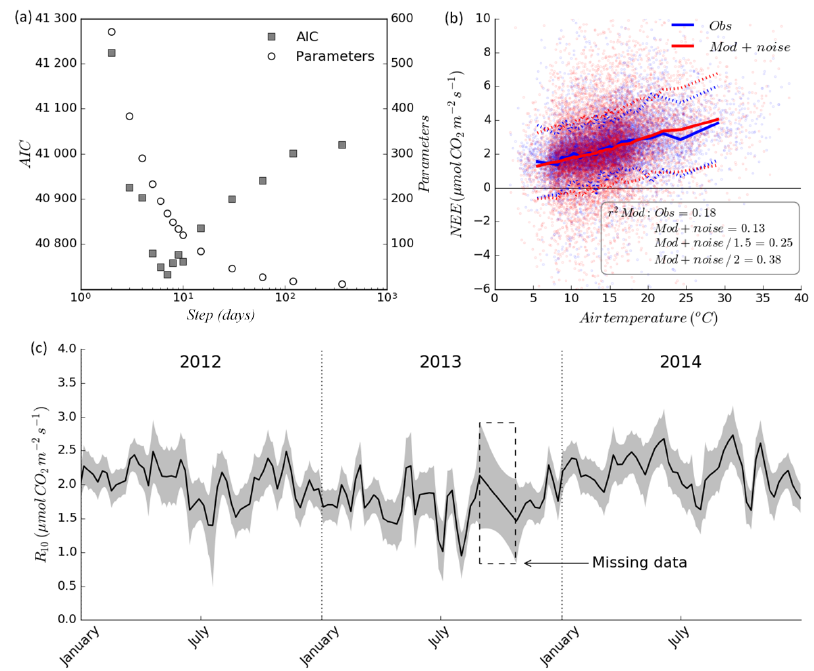
Figure 4. (a) Akaike’s information criterion (AIC, left-hand axis) and number of parameters (right-hand axis) for model with time-step- varying R 10 component. (b) Comparison of temperature response of observational data with modelled data degraded with data-derived random error (dashed lines represent ± 1SD, observational points are shown for reference). (c) Interpolated R 10 estimates derived from observational data optimisation using 7-day time step (black line), and 95% confidence interval for the mean (grey shading) for R 10 values extracted from 10 4 trials in which ER predicted from the empirical model was degraded with data-derived random